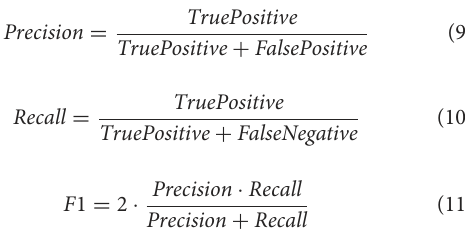
Figure 6 represented the generation results of each